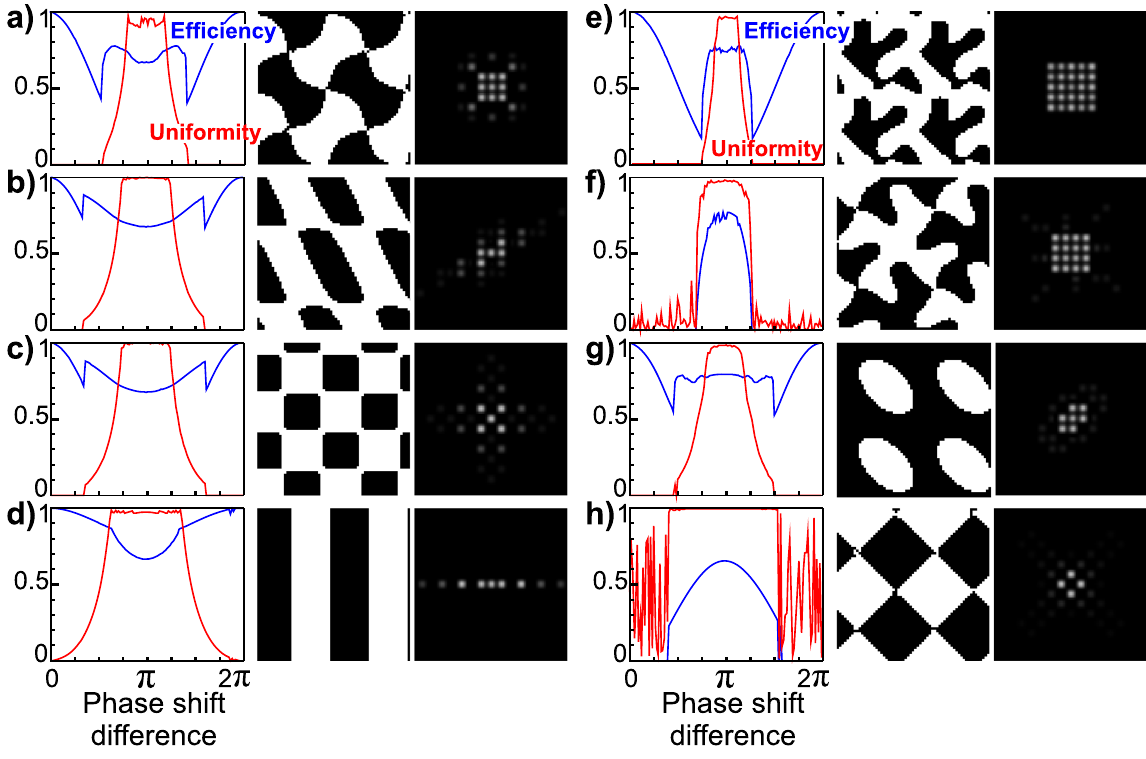
Figure 5. Simulation results for generating different diffraction orders distribution. From ( a ) to ( h ) are shown consecutively the optimization results for generating 9, 5, 5, 3, 25, 16, 7 and 4 equal intensity diffraction orders. For each case, the efficiency and uniformity are plotted against the phase shift difference. The best performing grating is presented, followed by the resulting diffraction orders distribution. The best designs were obtained for phase shifts different than π in ( a – d ) cases, while for ( e – h ) π phase shift resulted with the best performance.